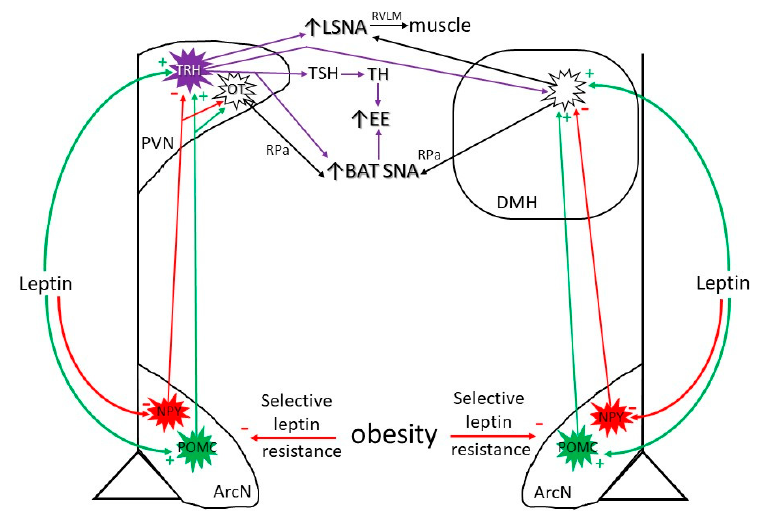
Figure 1. Hypothalamic neurocircuitry by which leptin increases SNA and activates the HPT axis. NPY: Neuropeptide Y; POMC: Pro-opiomelanocortin; ArcN: Arcuate nucleus; PVN: Paraventricular nucleus; TRH: Thyrotropin-releasing hormone; TSH: Thyroid-stimulating hormone; TH: Thyroid hormone; OT: Oxytocin; EE: Energy expenditure; BAT SNA: Brown adipose tissue sympathetic nerve activity; RVLM: Rostral ventrolateral medulla; RPa: Raphe pallidus; DMH: Dorsomedial hypothalamus. Green arrows: stimulatory; red arrows: inhibitory. See text for description and details.